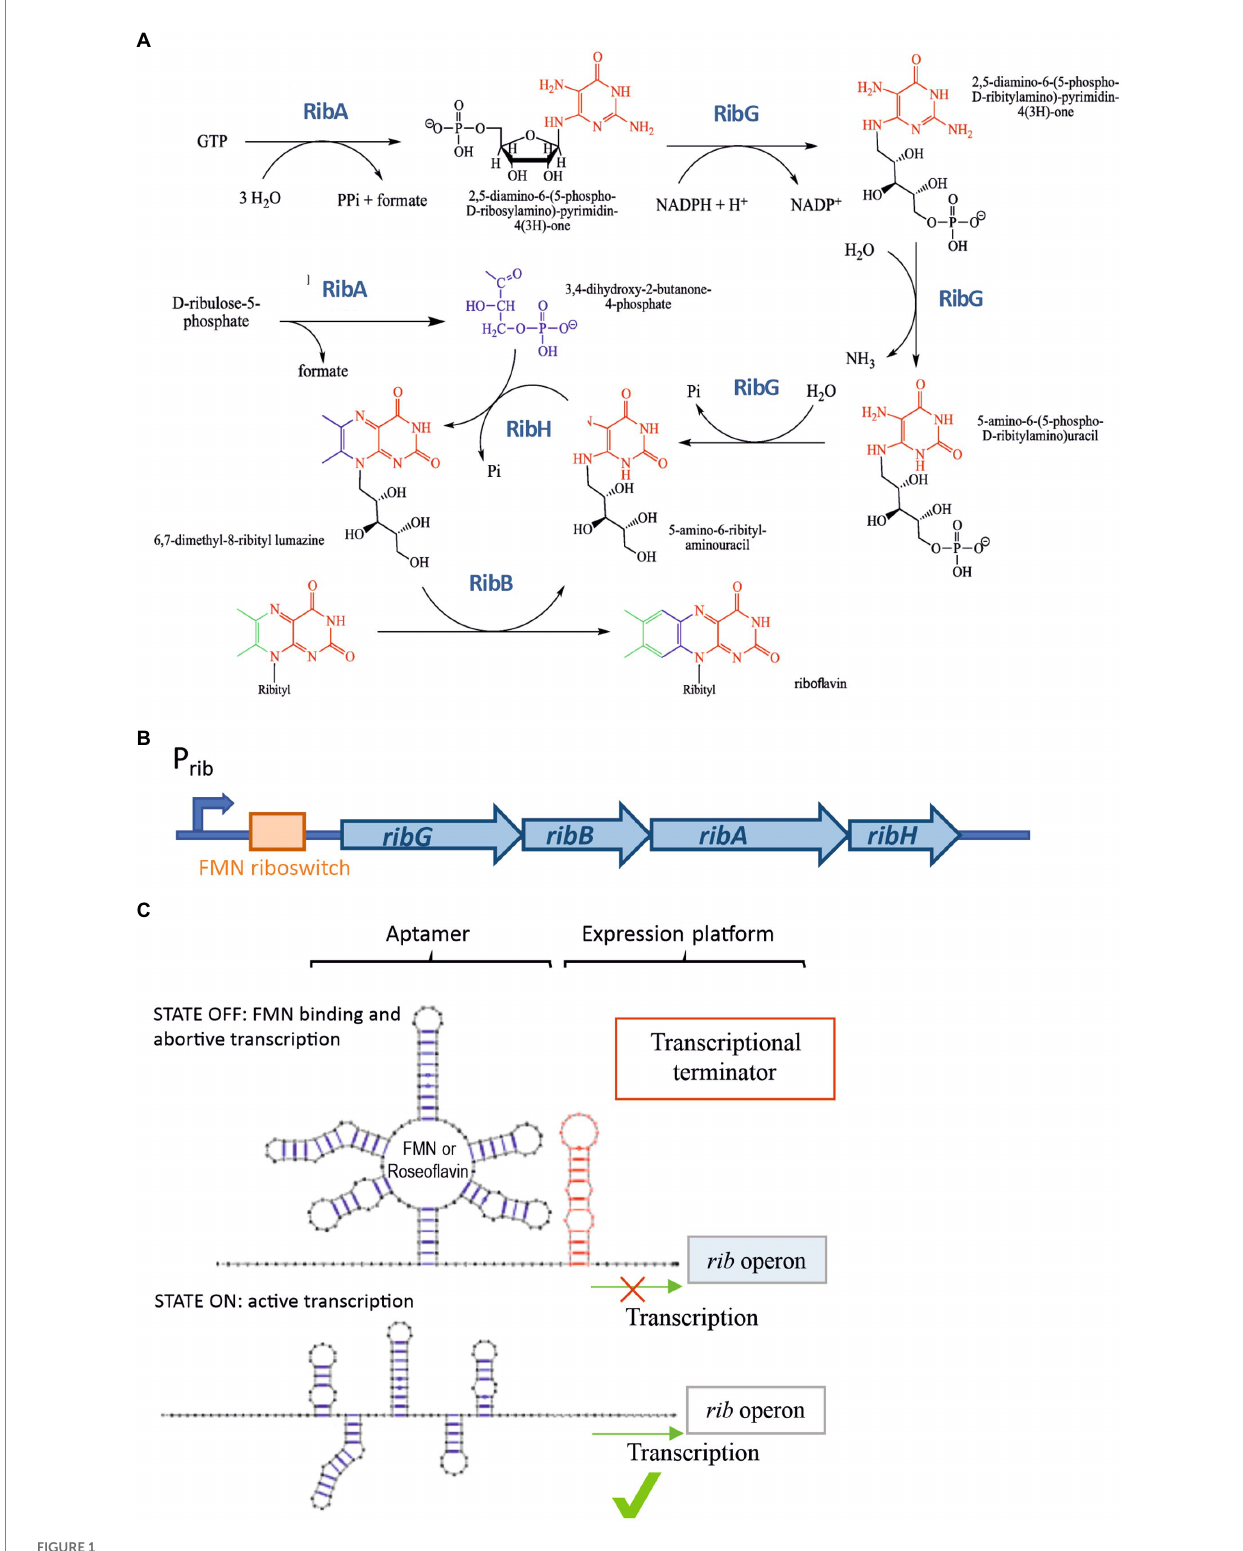
FIGURE 1 RF synthesis and regulation. (A) RF biosynthetic pathway. (B) The rib operon and its regulatory regions (promoter and FMN riboswitch). (C) Schematic representation of the rib operon riboswitch including the FMN binding sensing aptamer and the expression platform. Two alternative conformations of the regulatory domain. “OFF state” or FMN-bound state facilitating the formation of a ρ -independent transcriptional terminator in the regulatory element in the RNA, and the “ON state” in which an anti-terminator structure is formed in the absence of FMN enabling the transcription of the rib